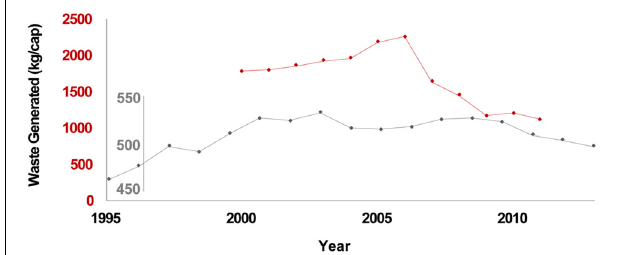
FIGURE 1 | California waste generation (red) and EU27 municipal waste generation (gray). Sources for CA and EU27 data are the California Department of Resources Recovery and Recycling (CalRecycle), and Eurostat,